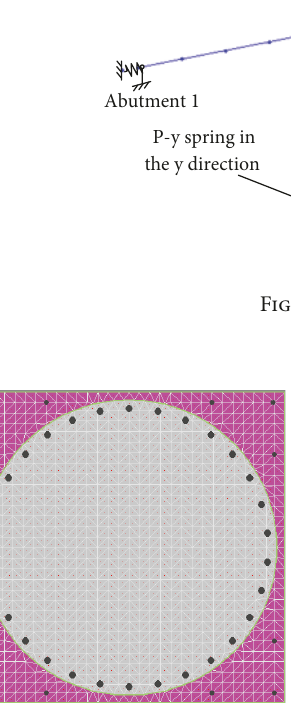
Figure 8: Fiber section of the columns.